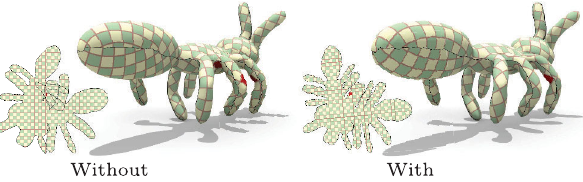
Parameterizations with/without bijective constraints. Without bijective constraints, a 2D point may be mapped to more than one point on the